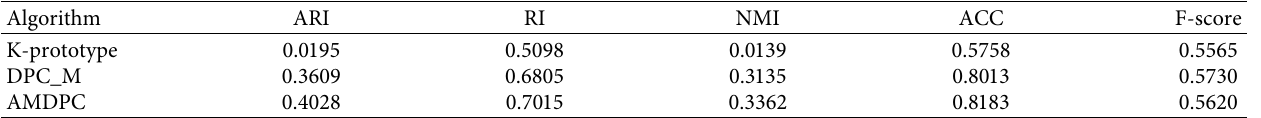
Table 5: Clustering results of Cleveland